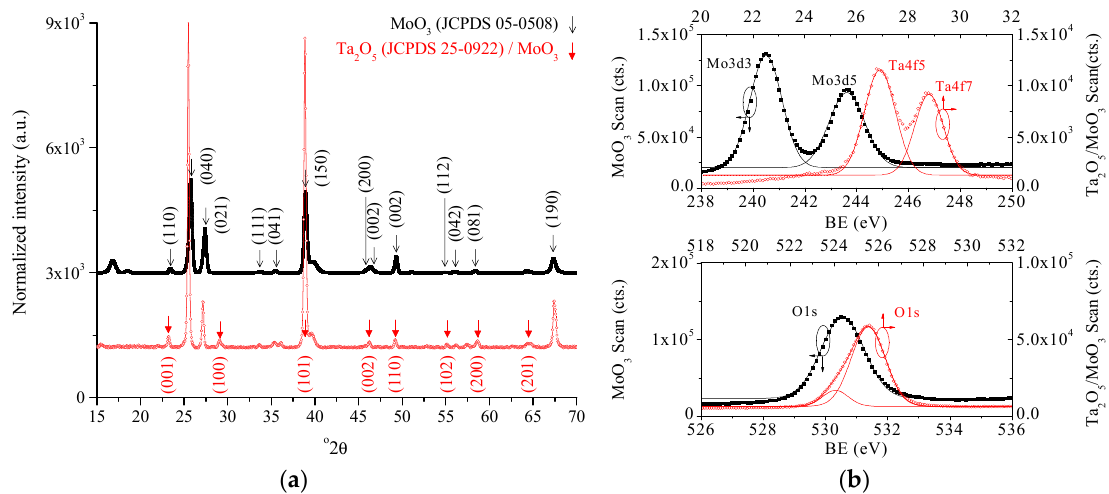
Figure 2. ( a ) X-ray diffraction (XRD) of the MoO 3 nanobelts and Ta 2 O 5 /MoO 3 nanobelts. ( b ) X-ray photoelectron spectroscopy (XPS) of the Ta4f5 and Ta4f7 binding energy peaks from the Ta 2 O 5 /MoO 3 nanobelts, and the XPS of the Mo3d3 and Mo3d5 binding energy peaks from the MoO 3 nanobelts (upper figure). XPS of the O1s binding energy peaks of MoO 3 nanobelts and Ta 2 O 5 /MoO 3 nanobelts (lower figure).